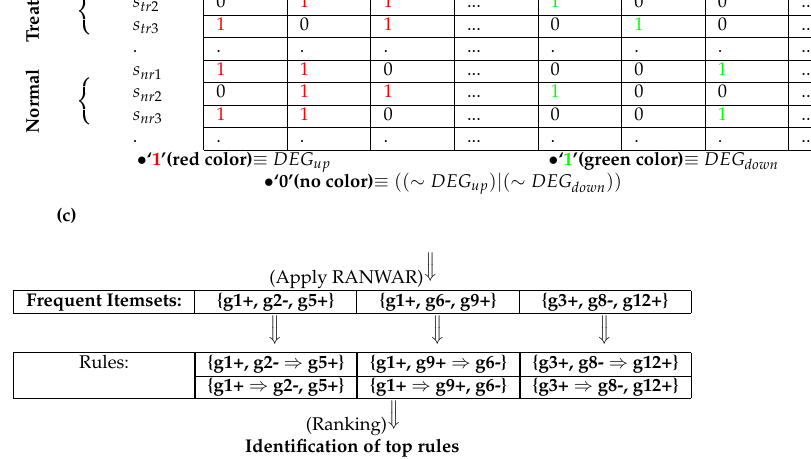
Figure 1. An example for performing the post-discretization: sub-figure ( a ) denotes the initial matrix containing differentially expressed genes ( DEG s); ( b ) represents the matrix after discretization; ( c ) depicts the matrix after post-discretization; ( d ) signifies the utilization of association rule mining and the identification of top rules, where “+” refers to up-regulation (also denoted by “1”), and “ to down-regulation (also denoted by “0”), s tr denotes diseased/treated samples, and s nr denotes normal